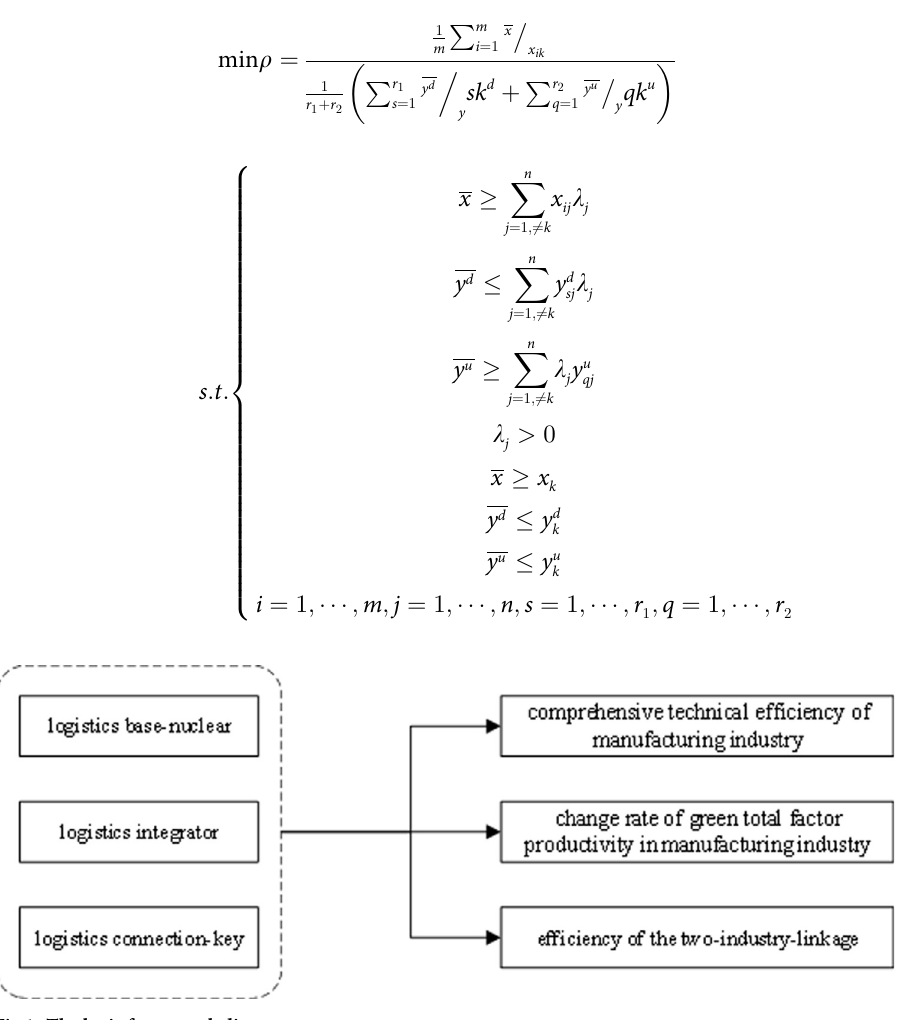
Fig 1. The logic framework